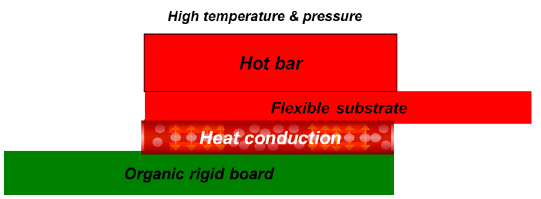
Figure 8. A schematic of TC bonding.